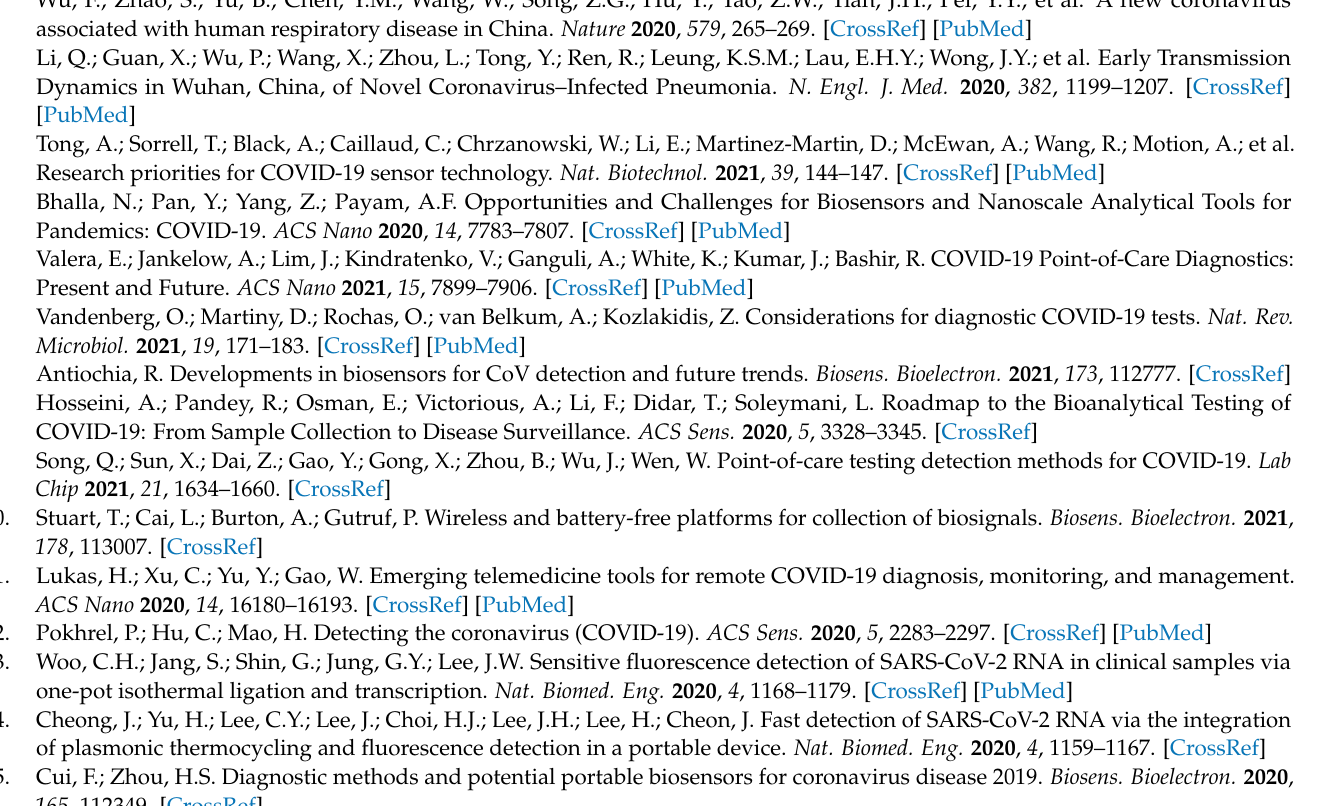
Figure S2: Relative standard deviation values in the quantification of the spike proteins in the case of PBS (Blue circle) and A. saliva (Magenta circle), Figure S3: Theoretical evaluation of the responsivity to particles adsorbed on the